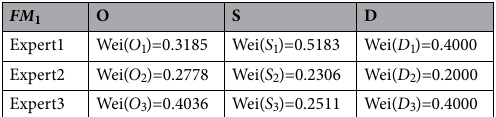
Table 7. The support degree of risk factors in FM 1 .